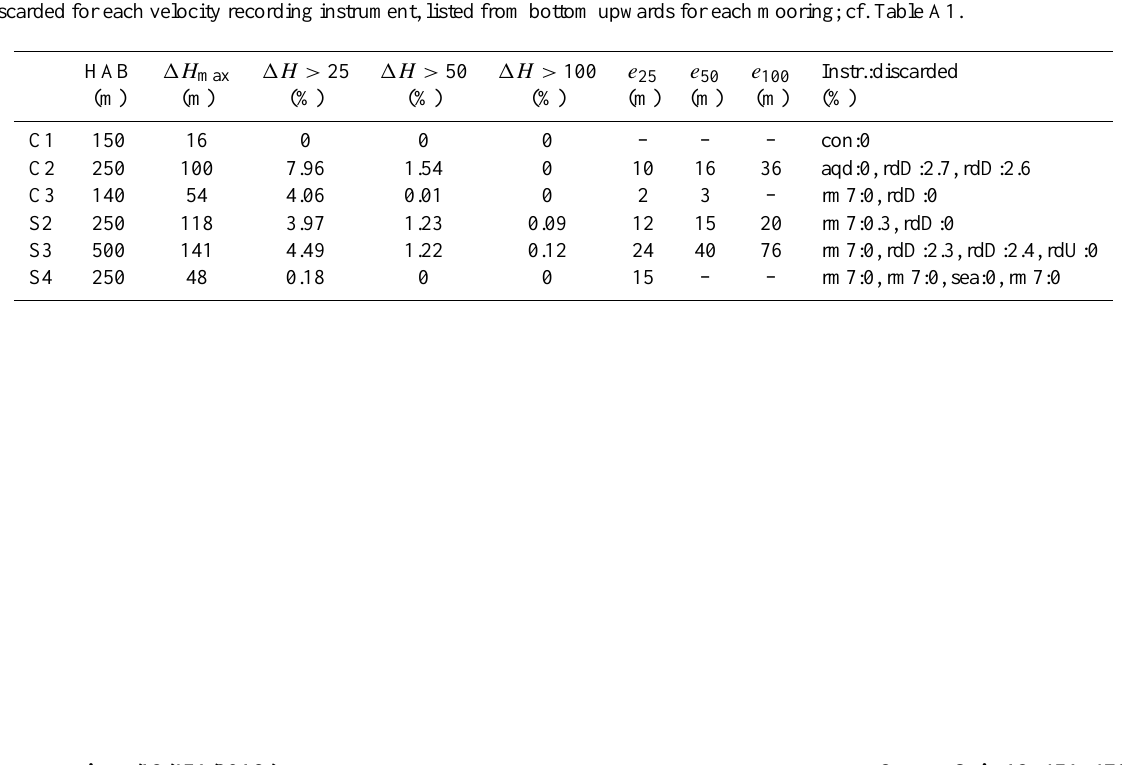
Table A2. Table showing maximum pulldown (from pressure sensors); percentage of time that pulldown is larger than 25, 50, or 100m, respectively; root mean square error e of the pulldown from the recorded pressure and modelled with MDD (Dewey, 1999); and the percent data discarded for each velocity recording instrument, listed from bottom upwards for each mooring; cf. Table